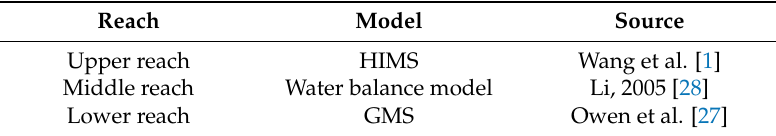
Table 2. The model simulating systems for each reach.